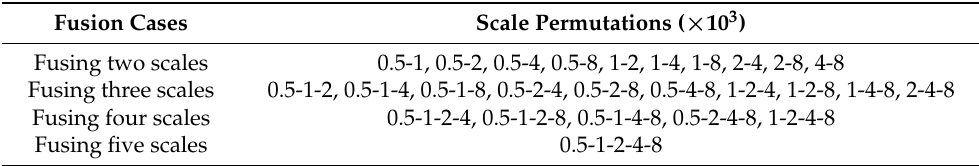
Table 6. Different fusion cases and scale